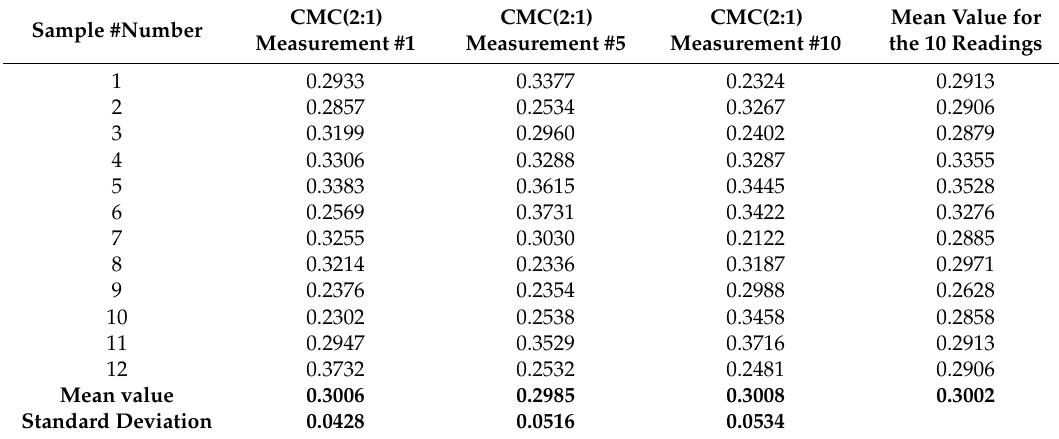
Table 2. Composition and characteristics of the fabric used for